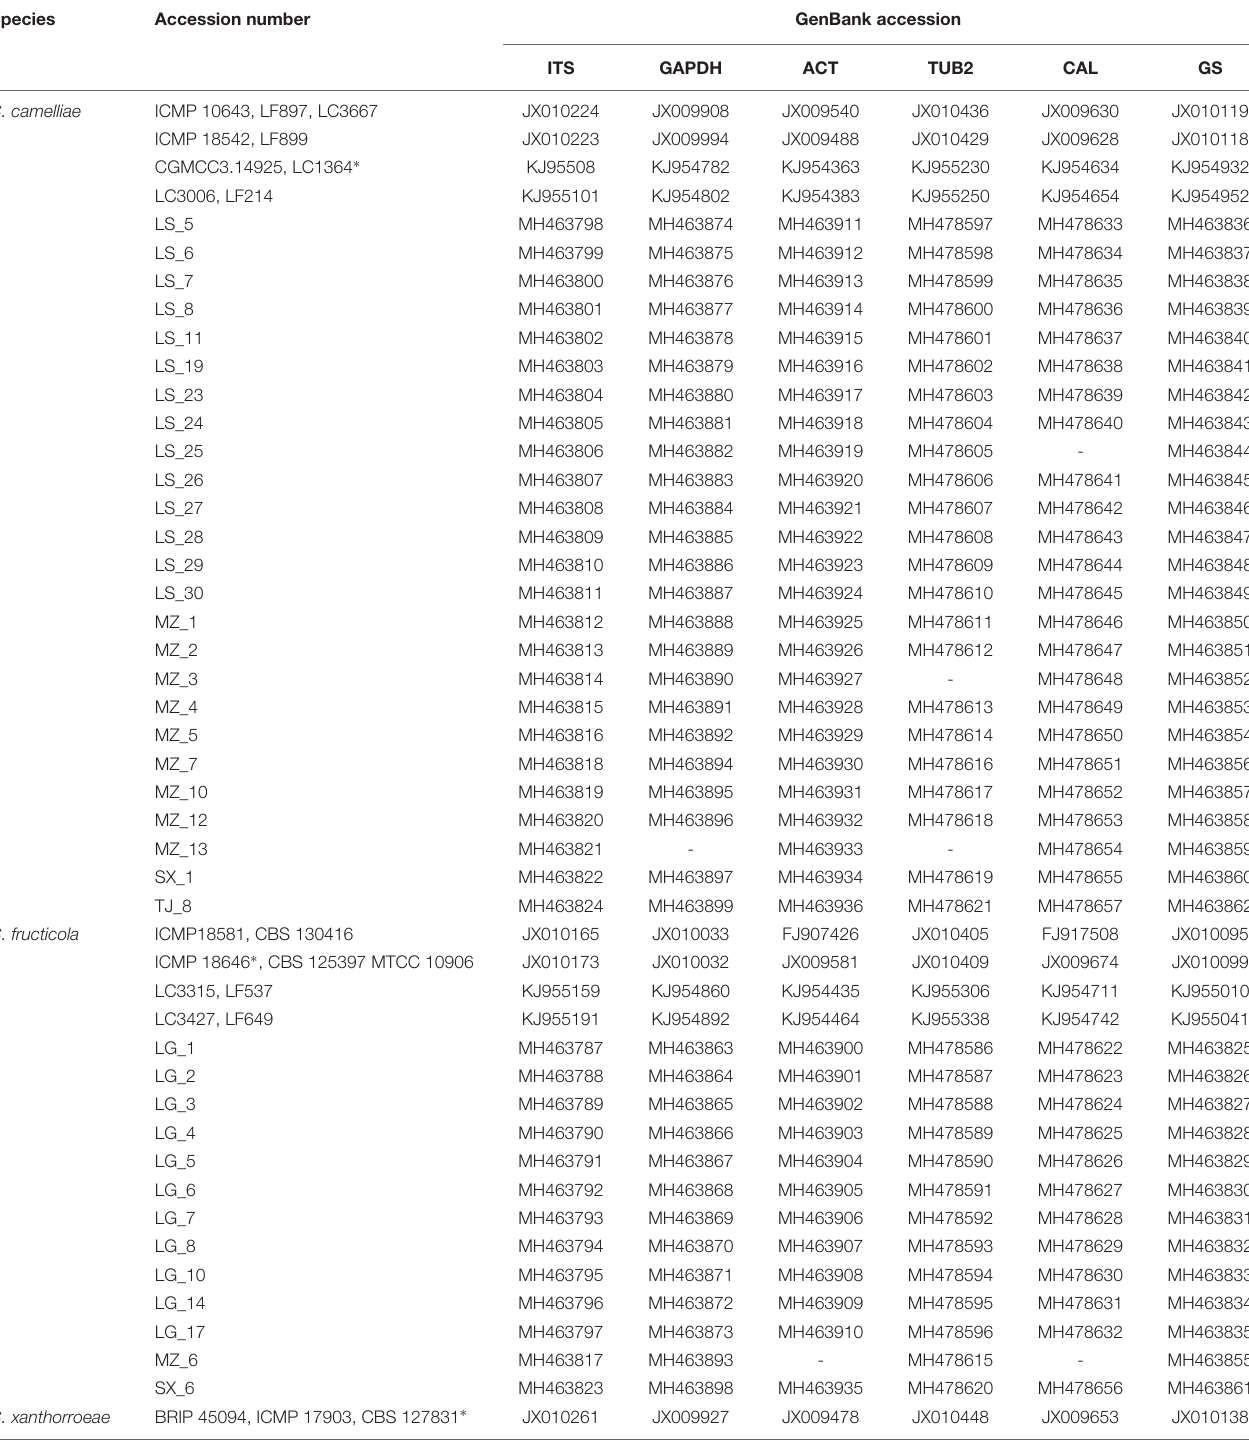
TABLE 2 | Isolates of the Colletotrichum spp. studied and GenBank accession numbers of the generated sequences.